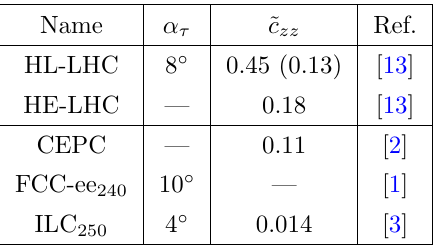
Table 15 . Upper bounds on the CP phase (cid:11) of the Yukawa coupling for (cid:28) leptons and the CP- violating coe(cid:14)cient ~ c zz entering the HZZ coupling. The result in parenthesis for the HL-LHC is obtained with the same method used for the CEPC